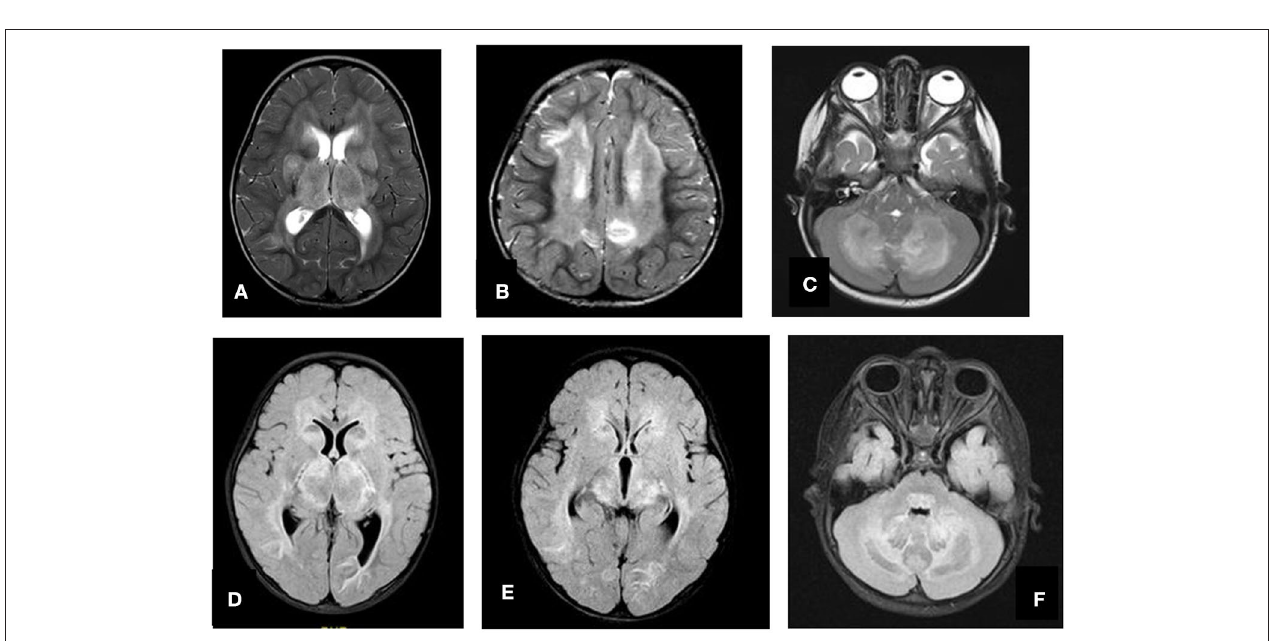
FIGURE 4 | Axial T2 (A–C) and FLAIR (D–F) showing swelling and abnormal high signal intensity of both thalami, basal ganglia, and cerebellum.